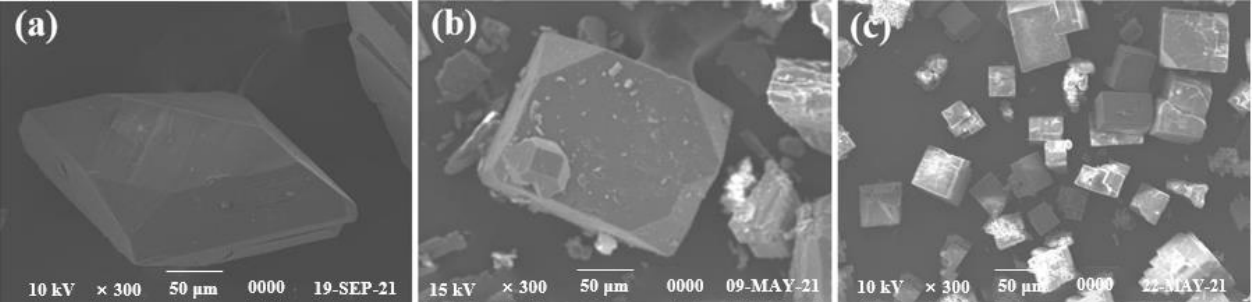
Figure 1. Acetic acid conversion of three catalysts prepared by pyrolysis of three different MOF-5 precursors at 750 ◦ C when the mass ratio of Zn(NO 3 ) 2 · 6H 2 O to H 2 BDC was 1:1, 1:0.5, 1:0.3.